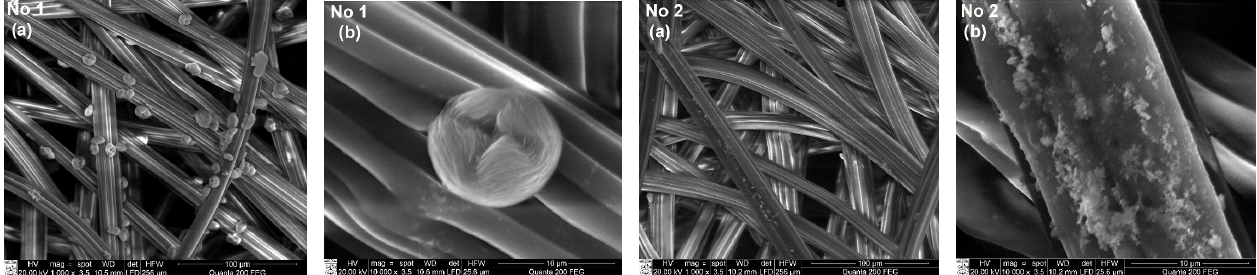
Figure 4. SEM images of fabric material sample FH (Flax/hemp, 50/50) treated with solutions No. 1 and No. 2. Magnification: ( a ) 1000 × ; ( b ) 10,000 × .